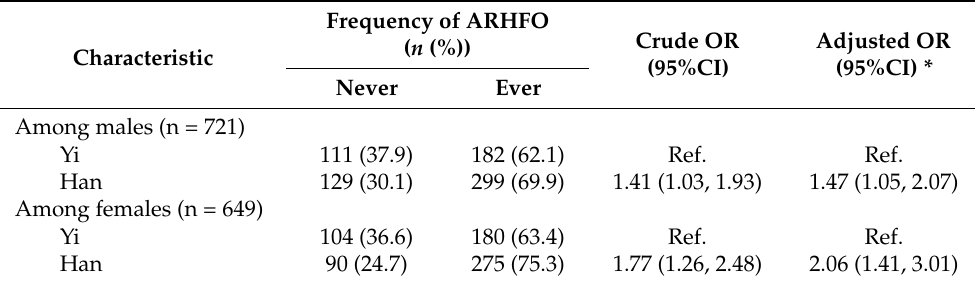
Table 5. Associations between ethnicity and frequency of harm from other’s drinking with adjustment for other demographic and socioeconomic characteristics, stratified by